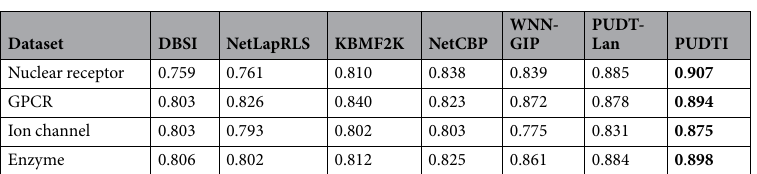
Table 4. The average AUC values of different DTI prediction methods on four